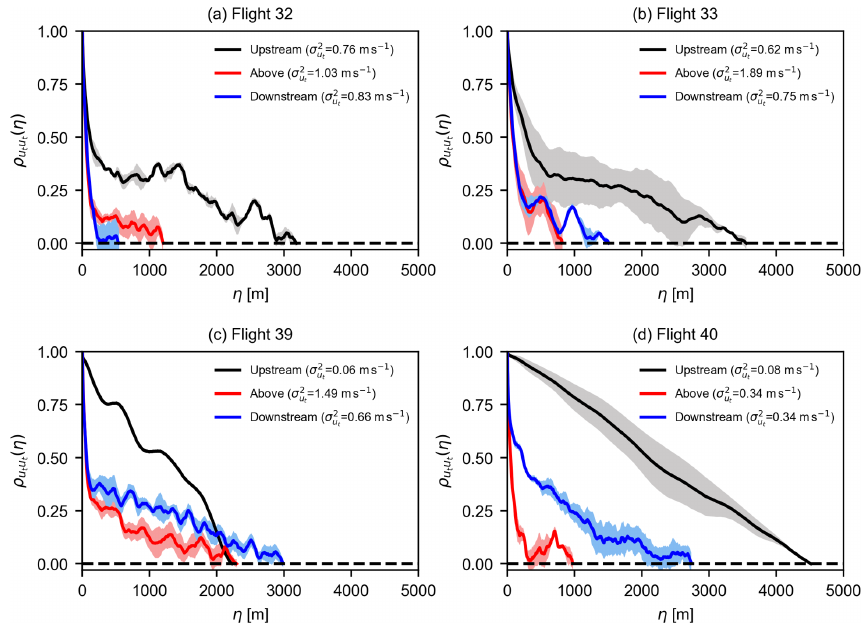
Figure 5. The autocorrelation of the along-wind component in the transverse direction plotted upstream, above, and downstream of the wind farms for the four flights mentioned in Table 1. The gray, red, and blue shaded areas represent the standard error of the mean (SEM) due to averaging of data from multiple flight legs. Flight 32 and 33 represent weakly stratified atmospheric conditions, while flight 39 and 40 were recorded when the atmosphere was strongly